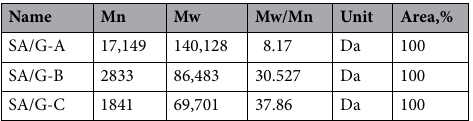
Table 2. GPC results of